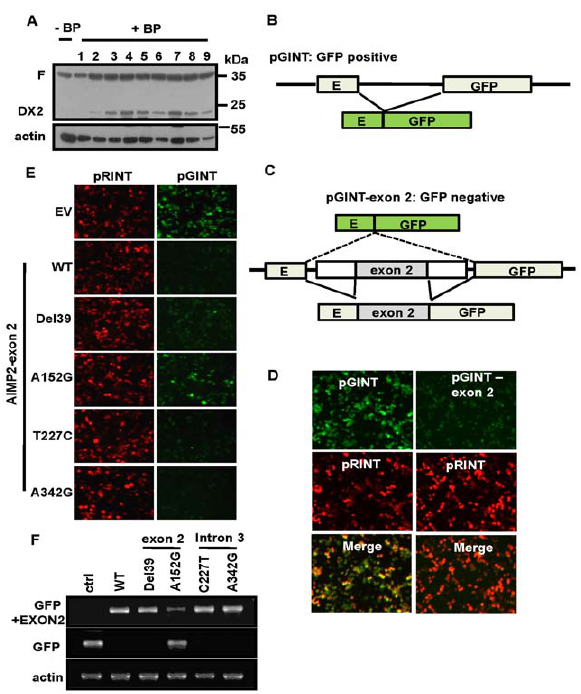
Figure 2. Splicing variant of AIMP2 is increased by carcinogen- induced mutation. (A) Normal lung WI-26 cells were incubated in the presence of BPDE for 4 weeks. The surviving colonies were isolated and further cultivated for additional 2 weeks after removal of BPDE to establish stable cell lines. The expression of AIMP2-F and –DX2 in each isolated cell line was determined by Western blotting with anti-AIMP2 antibody. (B) Schematic representation of the EGFP reporter cassette that monitors alternative splicing in cells (pGINT) [21]. Normal splicing process would delete the intervening DNA sequence that is inserted into the open reading frame of EGFP to restore the expression of EGFP. (C) The intervening sequence is inserted into the 146 base position of 717 bp open reading frame of EGFP. The DNA region spanning the 3 9 region of intron 1 (630 bp)-exon 2 (207 bp)-intron 2 (426 bp) of AIMP2 was inserted into the open reading frame of EGFP (pGINT-exon 2). If splicing skips exon 2, EGFP will be expressed (upper). However, the normal splicing including exon 2 will break the open reading frame of EGFP (lower). (D) pGINT (left) or pGINT-exon 2 (right) was introduced into HEK293 cells with pRINT (Red fluorescence protein reporter cassette that generates RFP through constitutive splicing intron), and expression of GFP and RFP was observed. (E) pGINT plasmids containing AIMP2 gene with the indicated mutations were tranfected into HEK293 cells and the expression of EGFP was determined. While pGINT empty vector generated EGFP, pGINT containing the wild type exon 2 and flanking intron regions reduced the expression of EGFP. The effect of the indicated mutations on the exon 2 splicing was monitored by the production of EGFP. All the transfectants showed similar degree of RFP, indicating that the difference in EGFP did not result from the variation of transfection efficiency. (F) Expression of the two transcripts (GFP transcripts with and without AIMP2 exon 2 insert) was also determined by